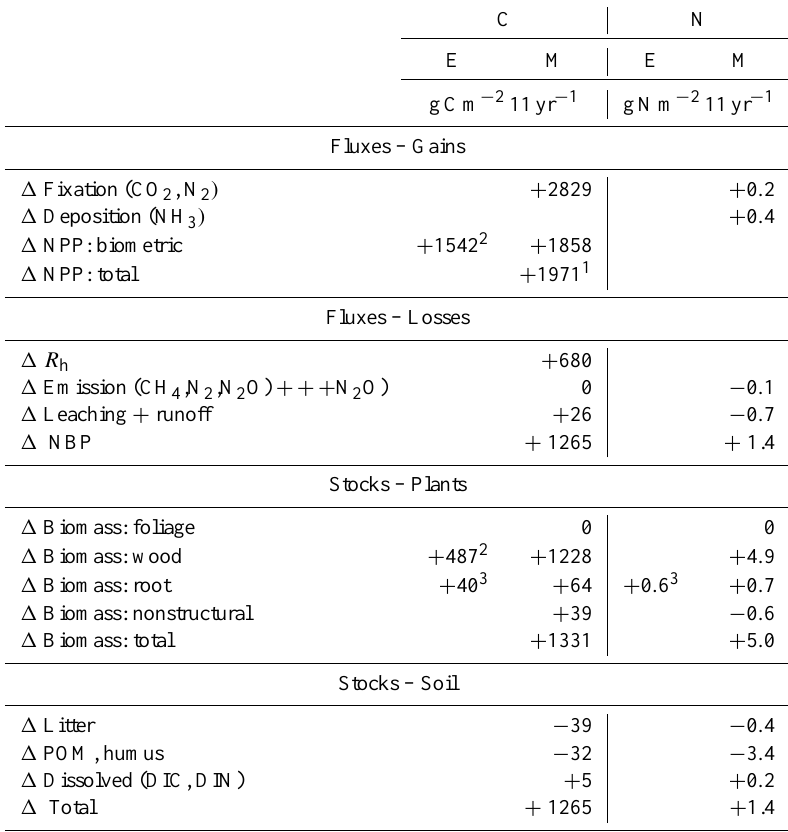
Table 2. Differences in cumulative fluxes and stocks of C and N estimated from biometric measurements (E) or modelled (M) at the